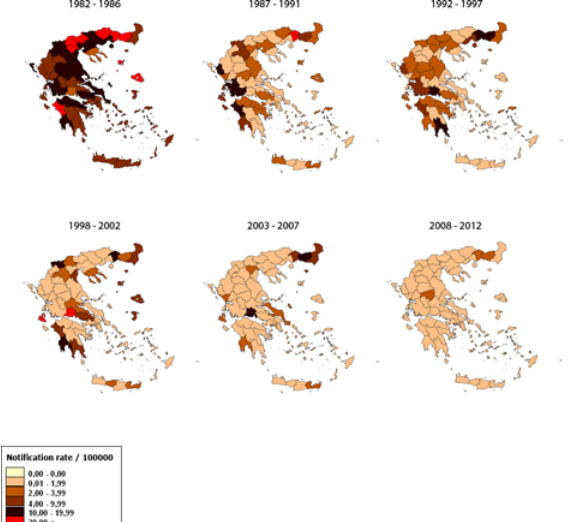
Figure 2. Geographical distribution of hepatitis A reported cases, Mandatory Notification System, Greece, 1982 – 2012 (5-year time intervals with the exception of 1992 – 1997 because of the following change of the